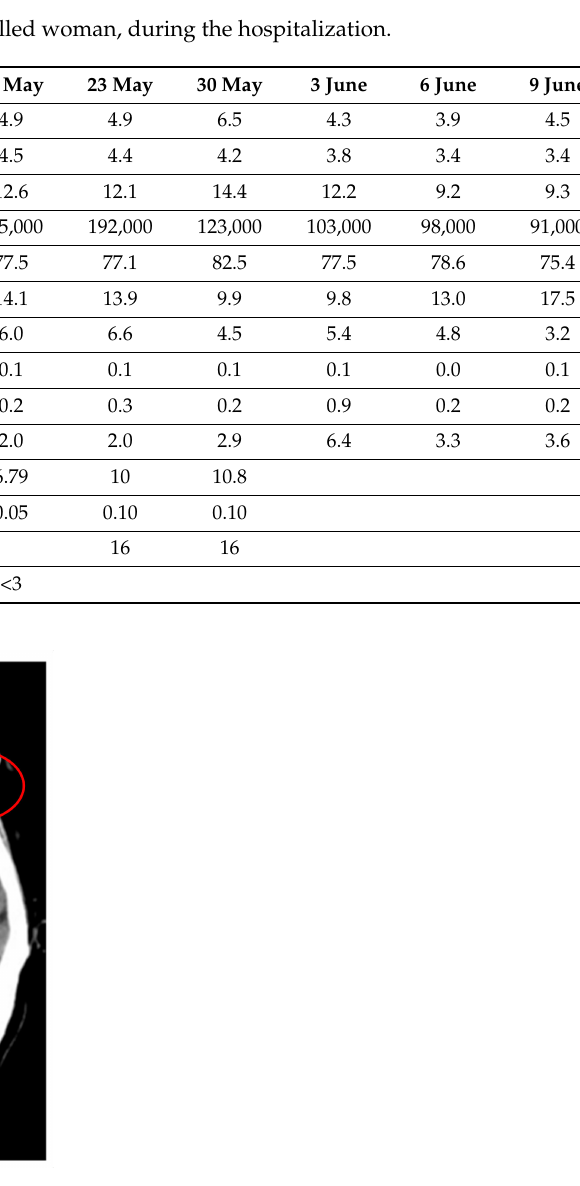
Figure 1. Head computed tomography (CT) scan revealing a large (2.35 cm) hypodense cerebrospinal fluid-like lesion (red